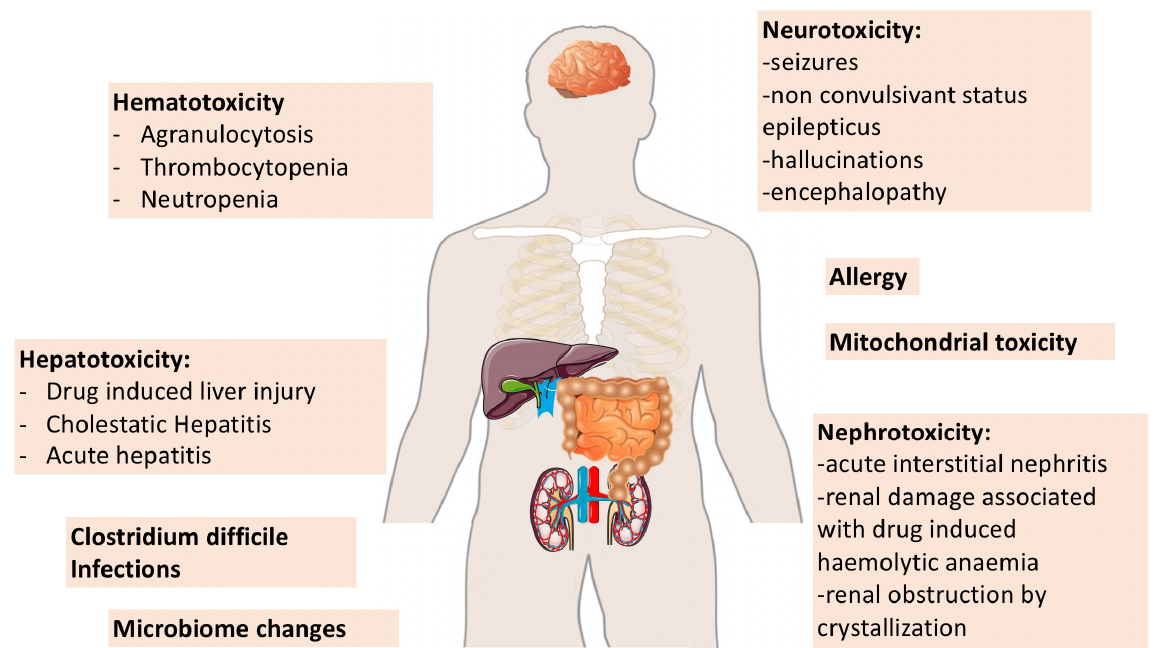
Figure 2. Schematic representation of different forms of collateral damage attributed to beta-lactams.